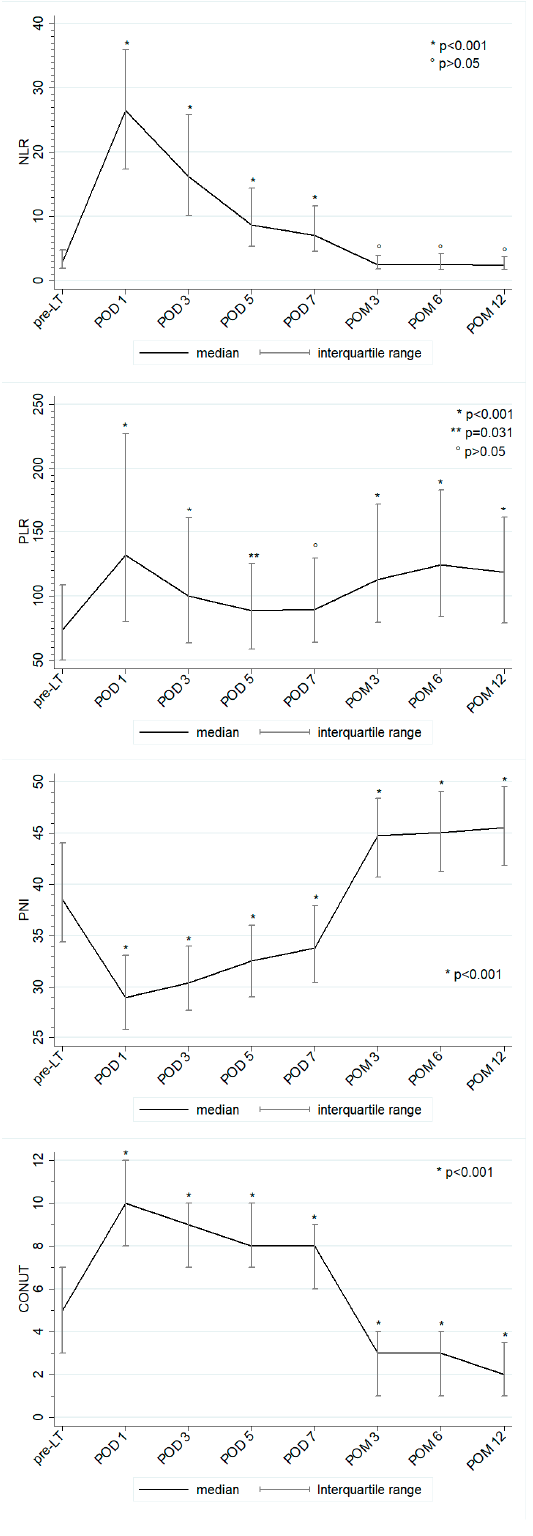
Figure 1. Postoperative trend of PLR, NLR, PNI, and CONUT. p values refer to the confrontation between post-LT and pre-LT biomarker values.